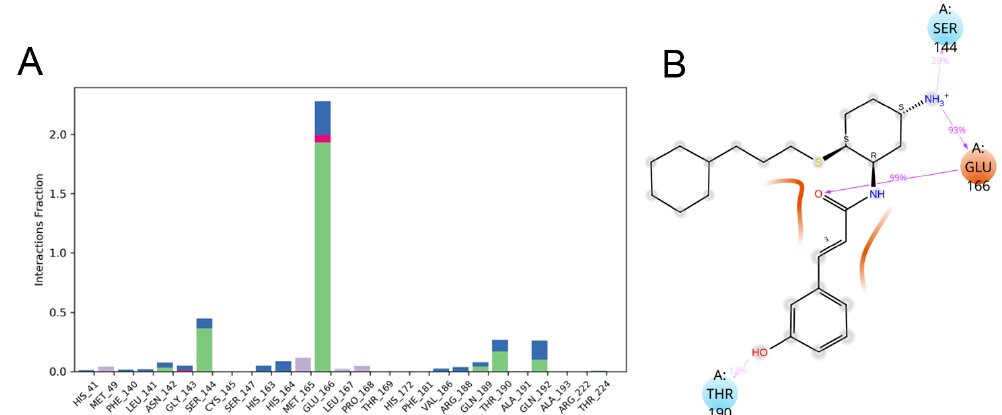
Figure 21. Analysis of ( A ) molecular interactions; and ( B ) type of contacts (2D interaction contour map with the key protein residues) for CM02 with SARS-CoV-2 M pro (PDB ID: 6LU7) after MD